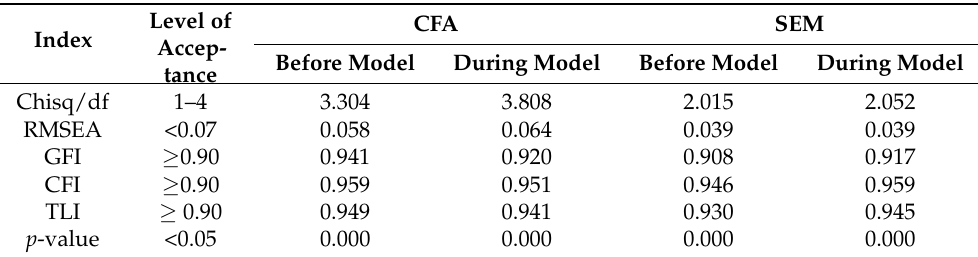
Table 4. Fitness index and results of CFA and